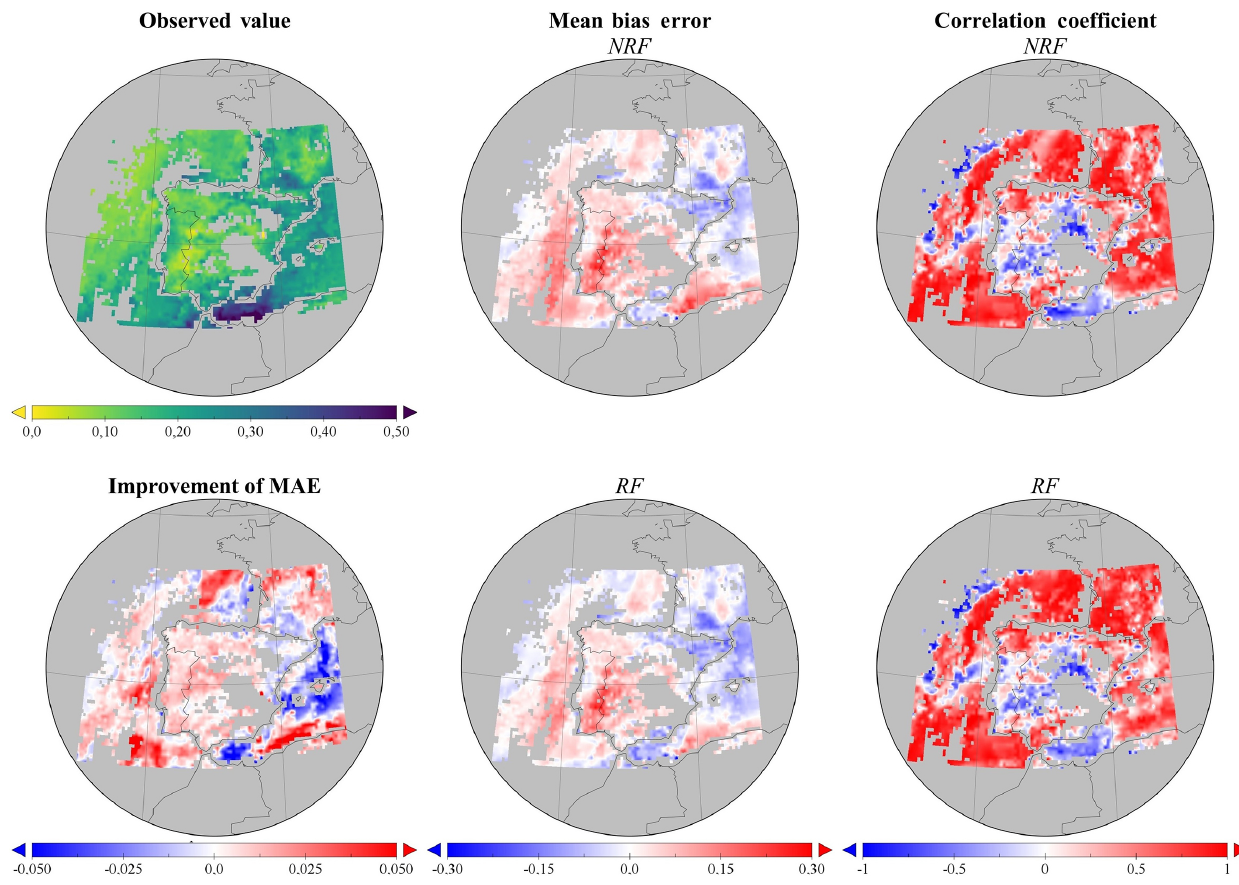
Figure 4. Comparison of AOD 550 model output vs. AOD 550 from MODIS data for the dust episode (temporal mean from 28 June to 12 July). AOD MODIS values (top left), improvement of the MAE due to the inclusion of RF (MAE in RF-NRF simulations, bottom left), MBE for NRF (top centre) and RF simulations (bottom centre). Correlation coefficient for NRF (top right) and RF (bottom right) simulations.